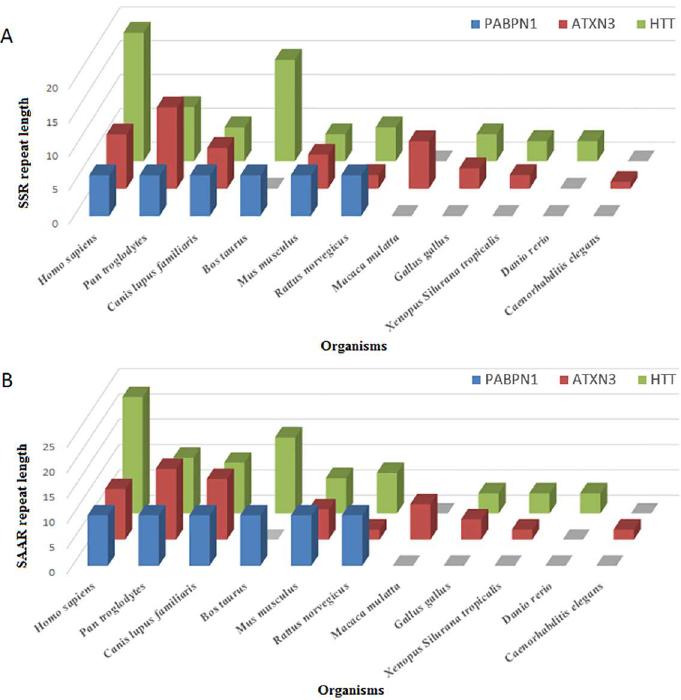
expansionthat causes OPMD, ATXN3 and HTT cause SCA3 and HTT, respectivelyupon abnormal expansionof PolyQ (CAG). (A) shows the length of SSR present in the CDS of the genes(B) shows the length of SAARs in the proteinsof the